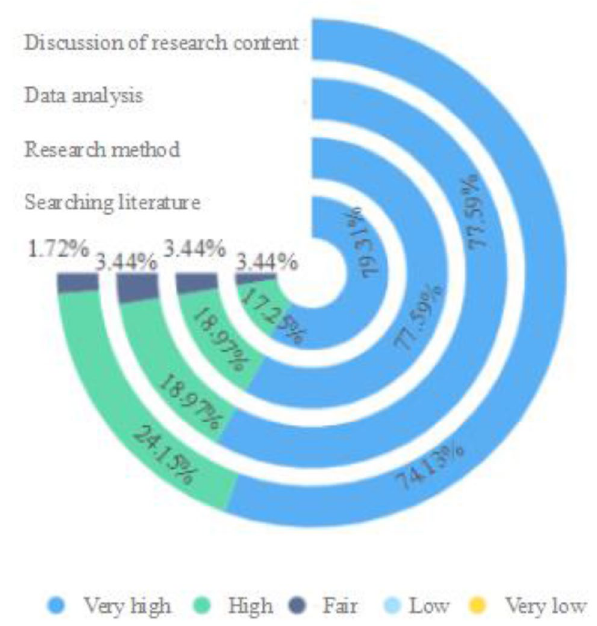
Fig. 5 Improvement of research skills